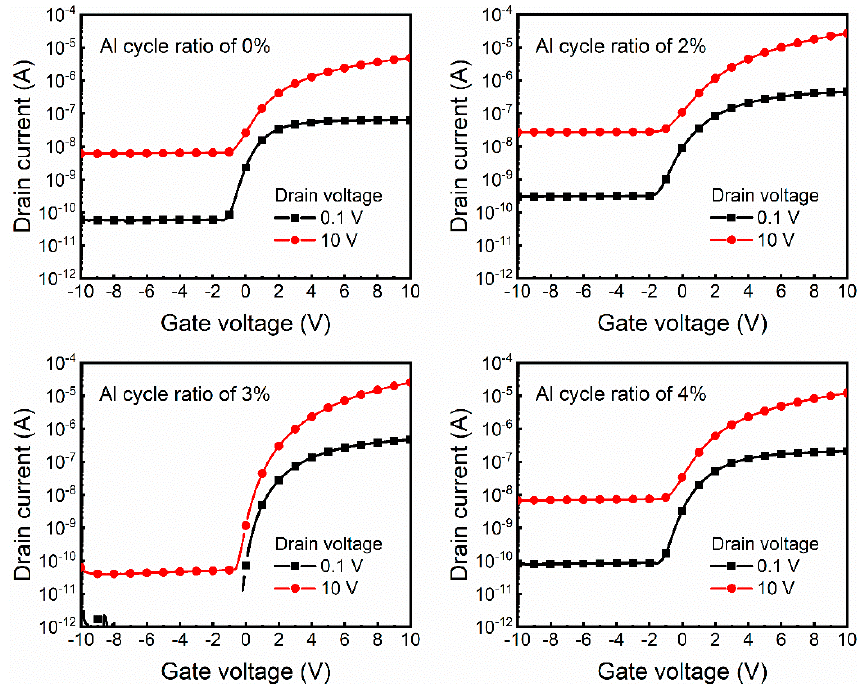
Figure 9. I D –V G curves of ZnO TFTs. ZnO and AZO films are used as the S/D electrode. Table 2. Electrical parameters of ZnO TFTs. Al cycle ratios of AZO S/D electrodes are 0%, 2%, 3%, and 4%, respectively.